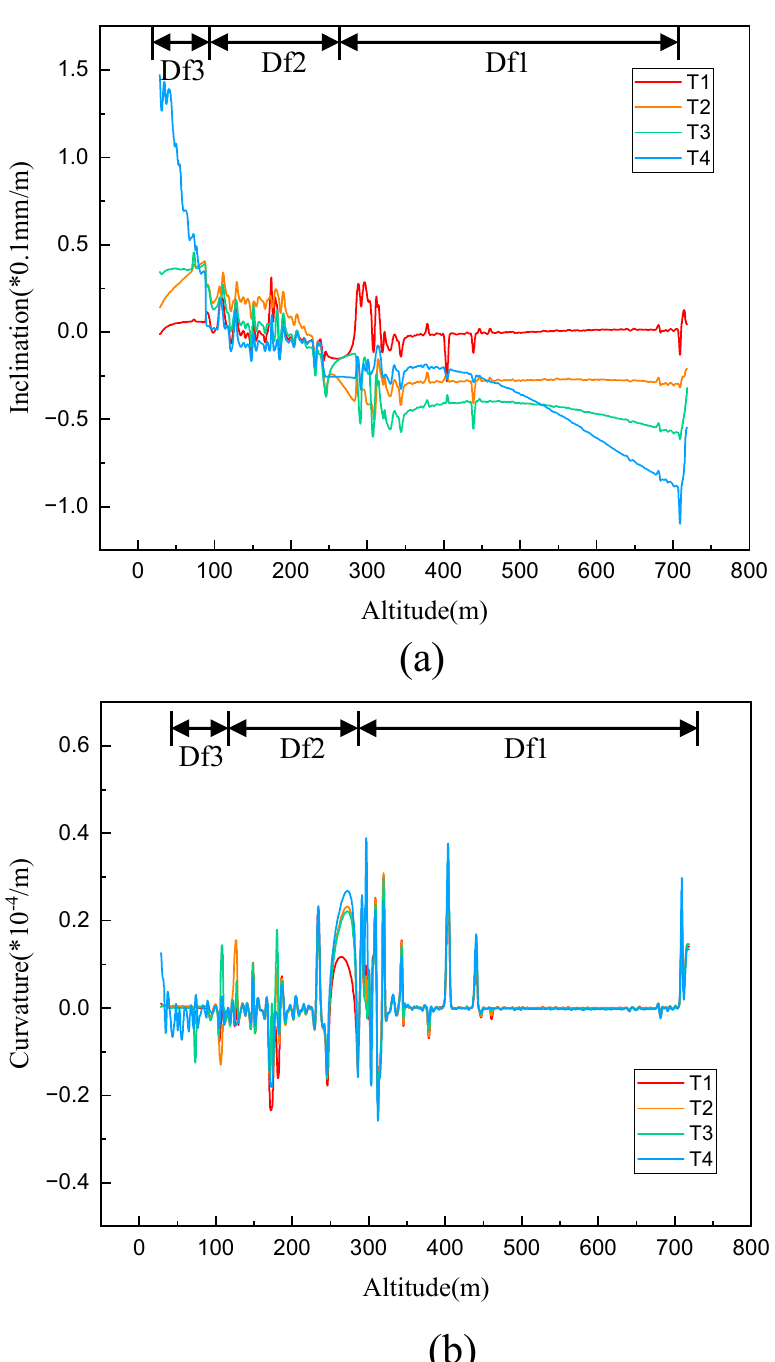
Figure 14. Inclination and curvature of Df shafts ( a ) Inclination of the Df shafts; ( b ) Curvature of the Df shafts.